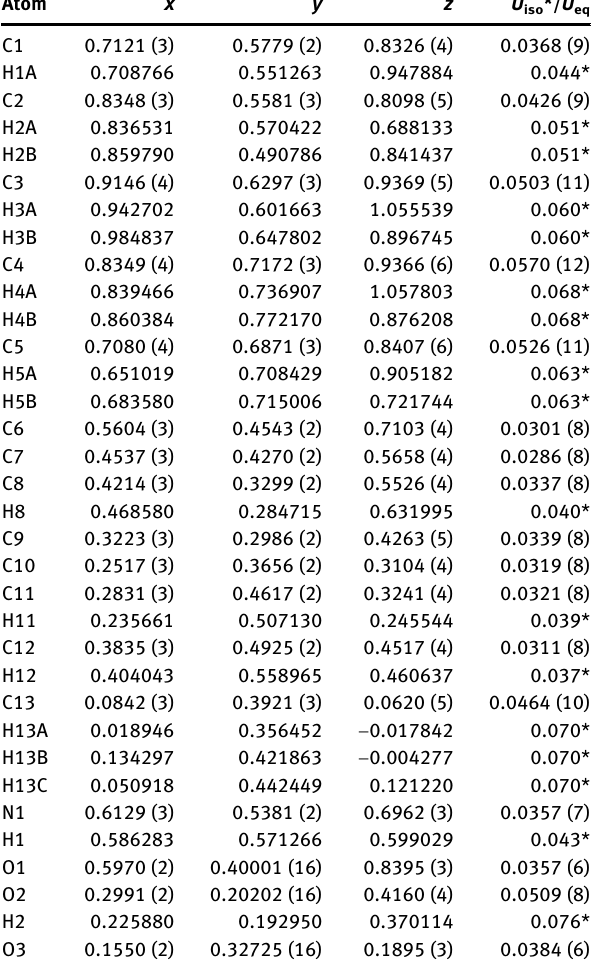
Table  : Fractional atomic coordinates and isotropic or equivalent isotropic displacement parameters (Å 